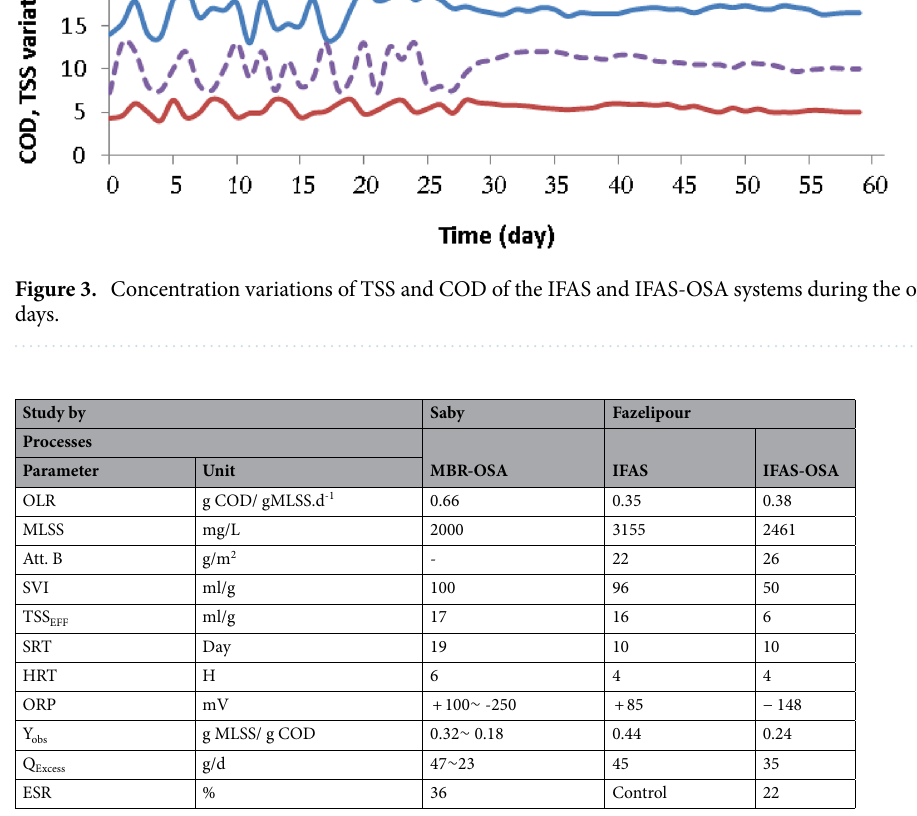
Table 6. The comparison of the operational parameters, ORP levels, sludge production (Y obs ), and excess sludge reduction of the IFAS and IFAS-OSA processes in the current study. OLR: Organic loading rate; MLSS: Mixed liquor suspended solid; Att. B: Attached Biomass; SVI: Sludge volume index; TSS Eff : Total suspended solids in the effluent; SRT: Sludge retention time; HRT: Hydraulic retention time; Q in : Influent flow; Q RAS : Returned activated sludge flow; ORP: Oxidation reduction potential; Y obs : Observed yield coefficient; S Excess : Excess sludge; ESR: Excess sludge